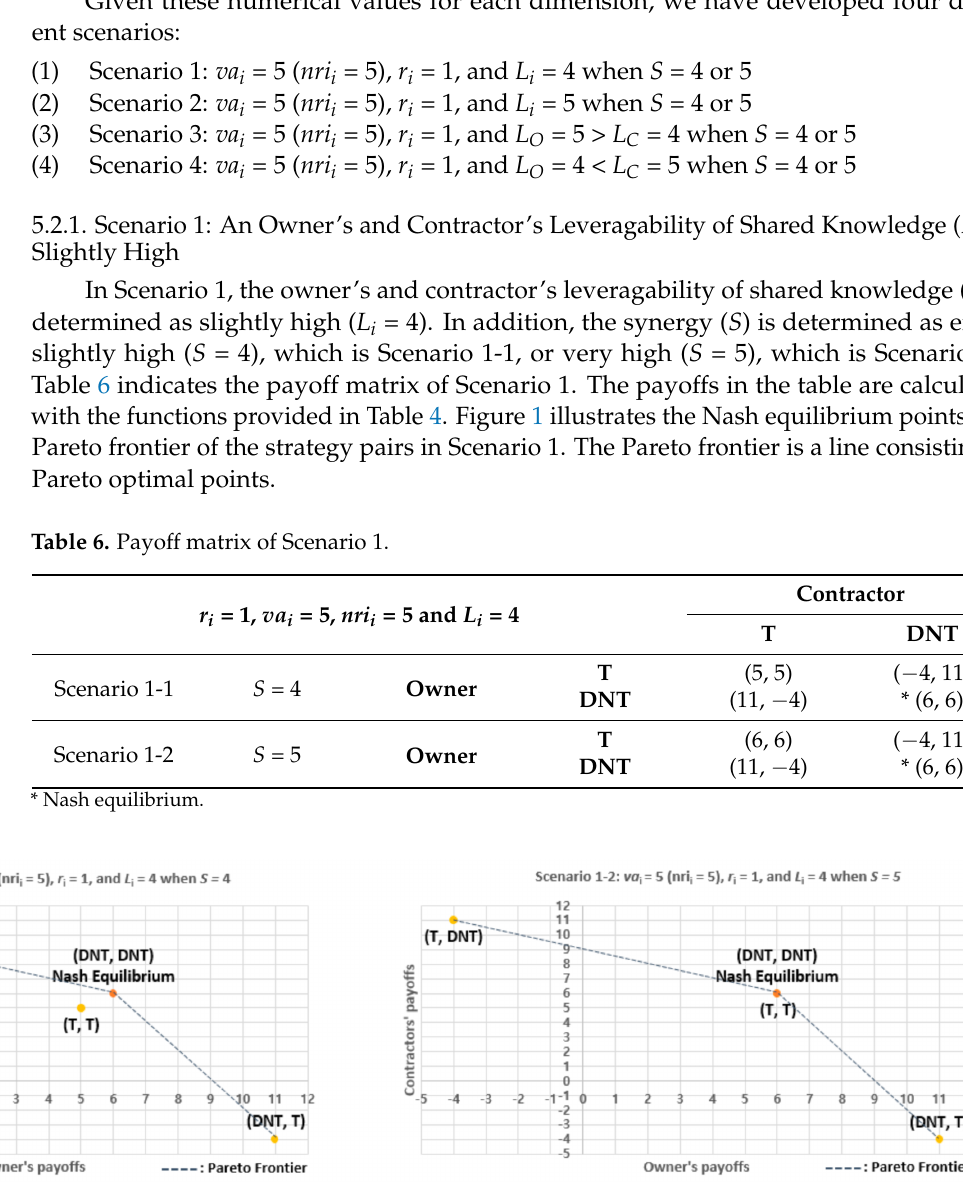
Figure 1. Nash equilibrium and Pareto frontier in Scenario